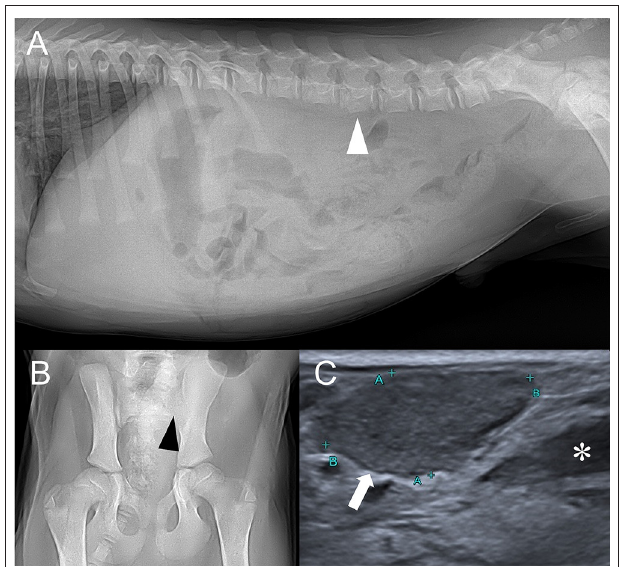
FIGURE 1 | Right lateral abdominal (A) , ventrodorsal coxofemoral joint (B) radiographs, and abdominal ultrasound depicting sublumbar lymph node (C) . (A) Irregular ventral margin of the 4th lumbar vertebra (white arrowhead) and decreased serosal detail are found. (B) Left sacroiliac joint is radiolucent and its bone margin (black arrowhead) is indistinct. (C) Enlarged sublumbar lymph node (white arrow) and anechoic trapped retroperitoneal fluid (asterisk) are noted.